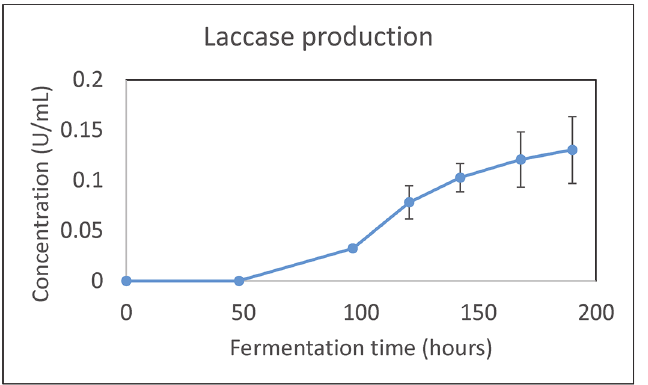
Fig 5. Laccase production by N . crassa with induction by 3 μ M cycloheximide induction at 48 hours into the fermentation. Results shown are the means of biological triplicates with the error bars representing the standard